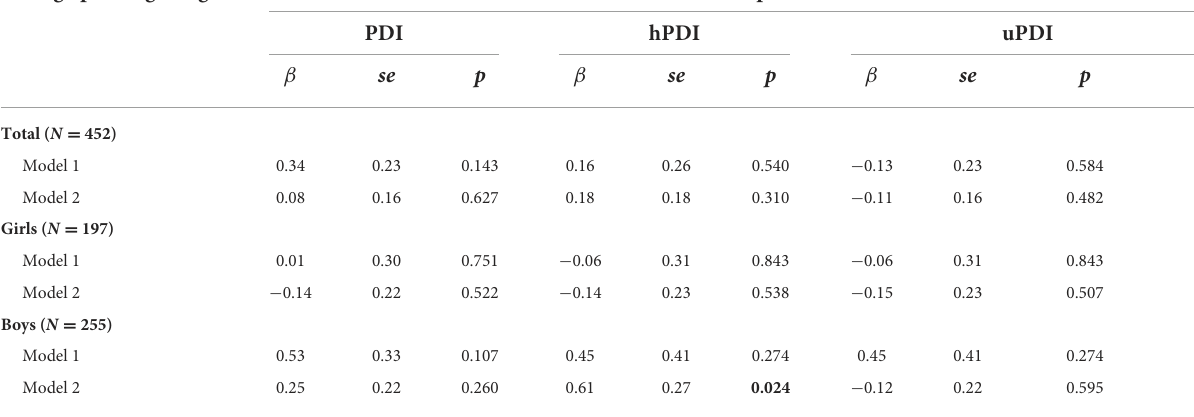
TABLE 6 Associations of plant-based diet index scores with handgrip strength. Handgrip strength,